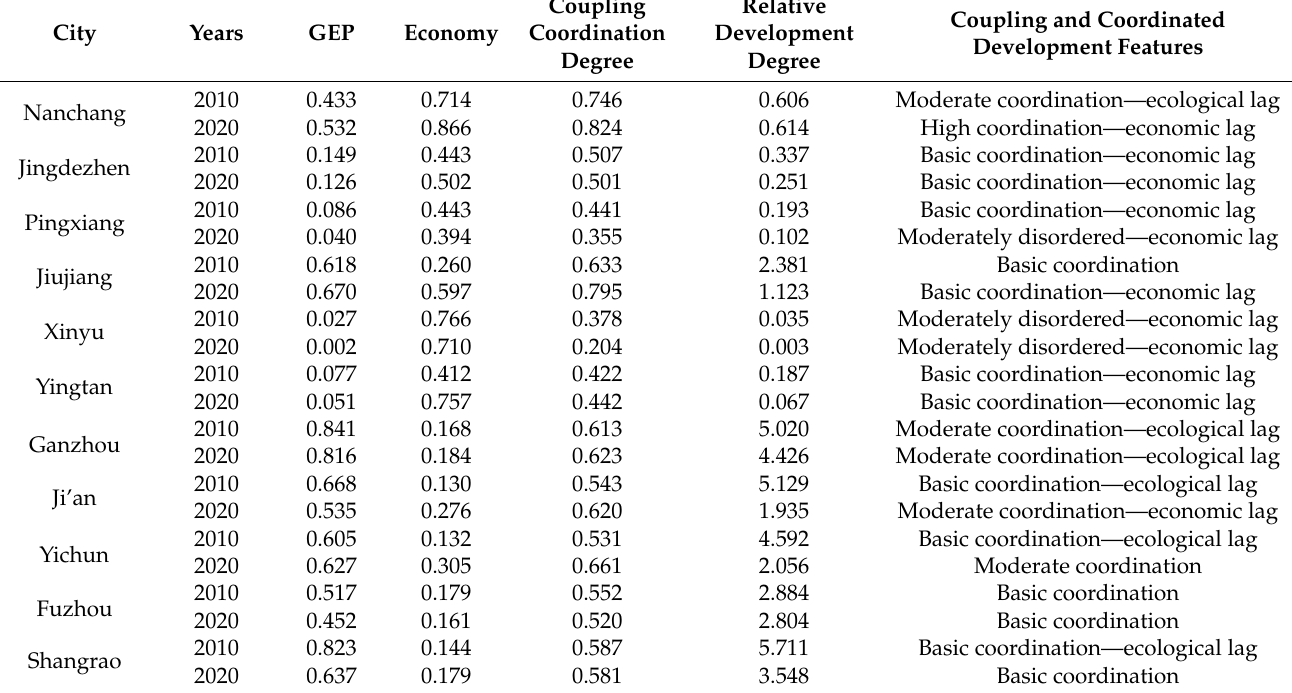
Table 8. The comprehensive index and coupling coordination calculation results of GEP and economic development in Jiangxi Province in 2010 and